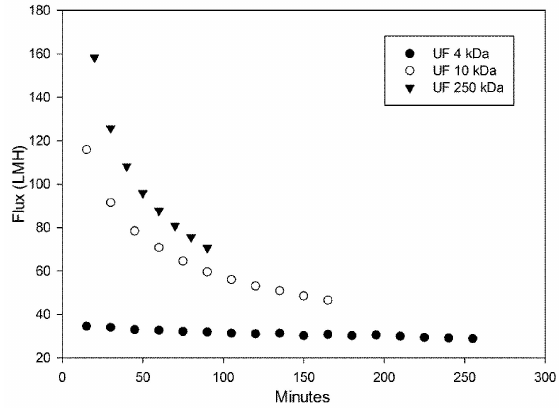
Figure 1. Flux-time profile of the UF membranes at constant pressure of 3.0 bars. Data in the figure indicates average fluxes of all